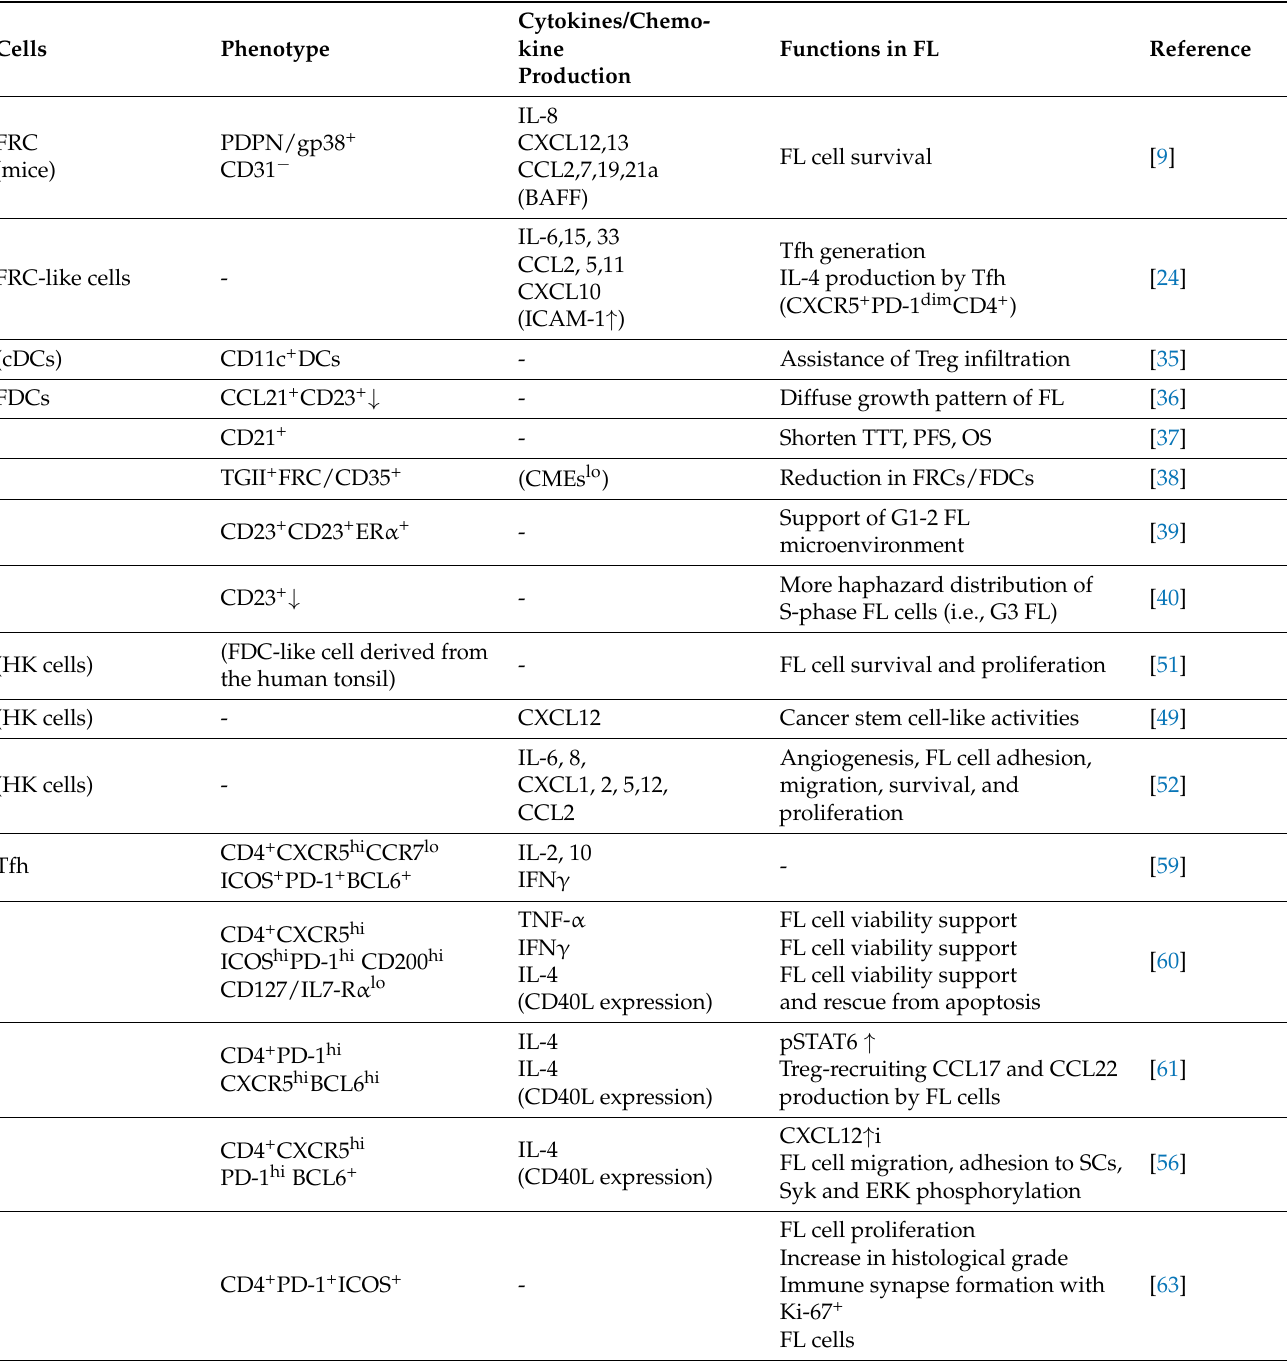
Table 1. Cell components in the microenvironment of follicular